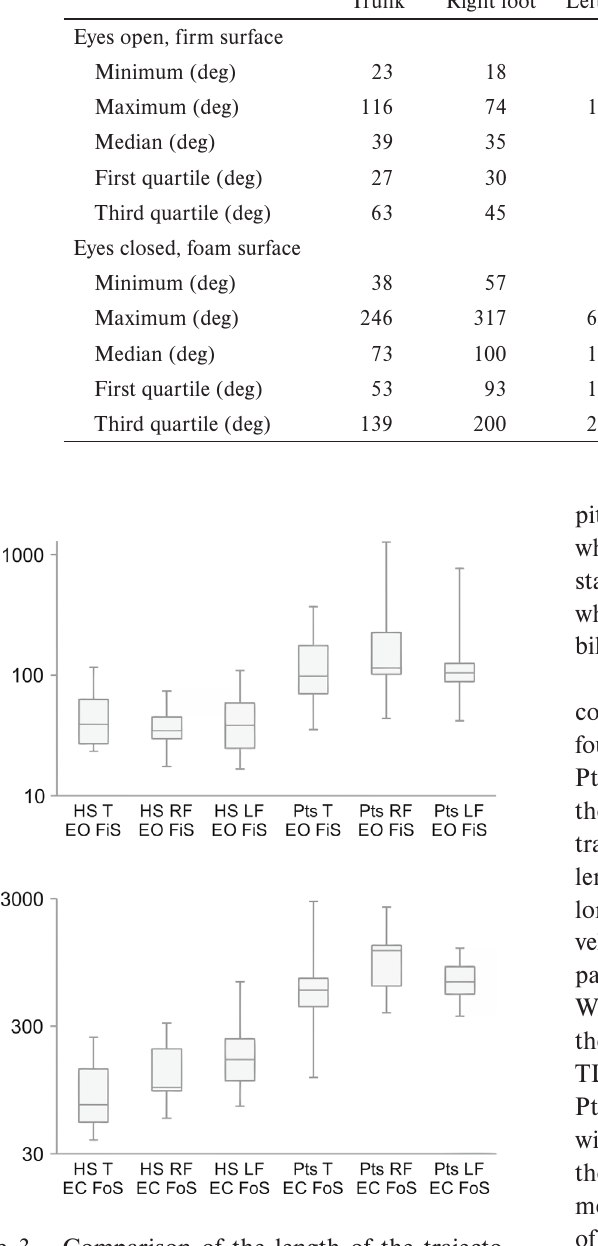
Descriptive statistics of the length of the trajectories of trunk, right foot and left foot of healthy subjects and patients standing on a firm surface with eyes open and foam surface with eyes closed Healthy subjects Patients